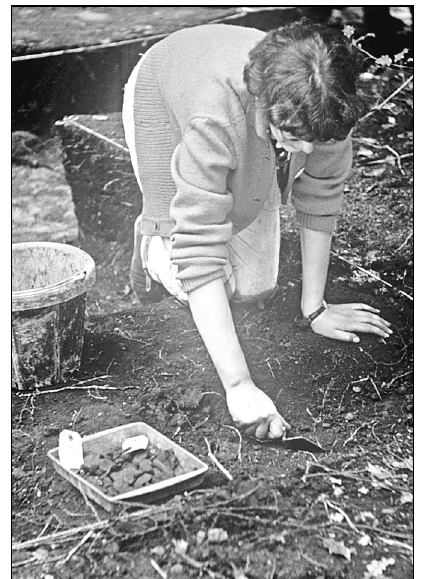
Figure 5 Part of a dump of waster pottery found at the Highgate Wood site in 1967, under